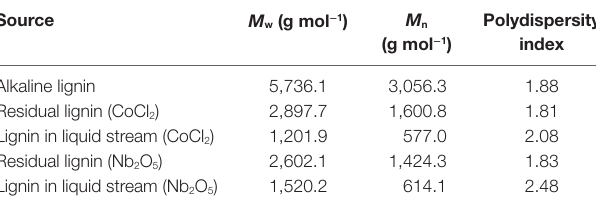
Table 3 | Molecular weight of untreated lignin and oxidized lignin